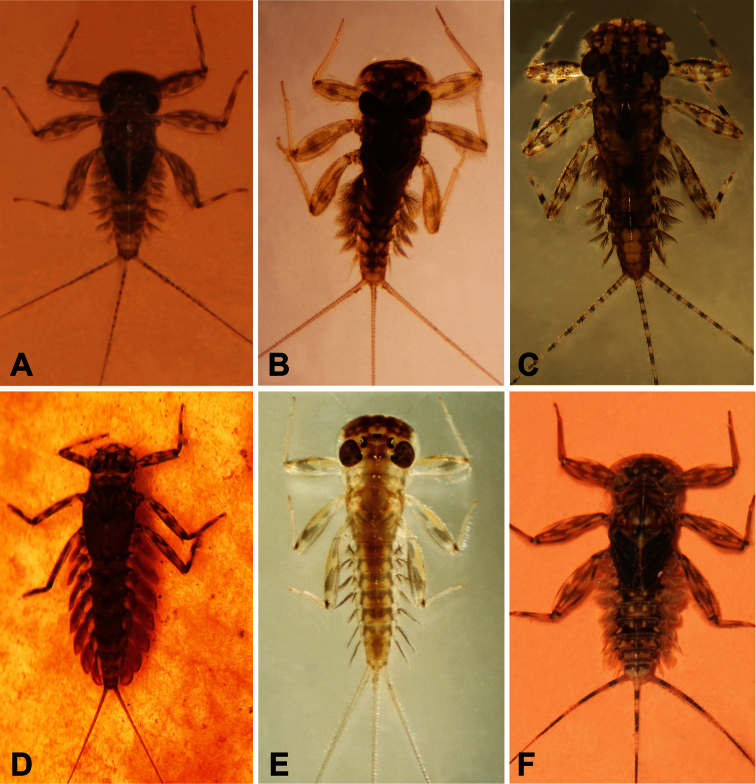
A Habitus of Asionurus namnaoensis Braasch & Boonsoong, 2010 B habitus of Asionurus primus Braasch & Soldán, 1986 Chabitus of Compsoneuria thienemanniUlmer, 1939 Dhabitus of Epeorus khayengensis Boonsoong & Braasch, 2010 E habitus of Rhithrogena tonkinensis Soldán & Braasch, 1986 F habitus of Thalerosphyrus sinuosus Navás, 1933.